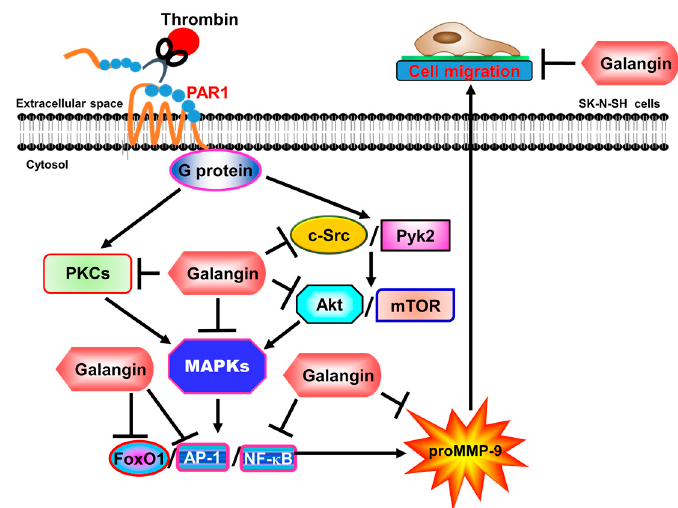
Figure 7. The schematic signaling pathways involved in galangin inhibiting the MMP-9 expression in SK-N-SH cells challenged with thrombin. Galangin inhibits MMP-9 expression by attenuating c-Src, Pyk2, PKC α / β / δ , Akt, mTOR, p42/p44 MAPK, p38 MAPK, and JNK1/2 phosphorylation to decrease NF- κ B, AP-1, and FoxO1 activation and ultimately reduces SK-N-SH cell migration.